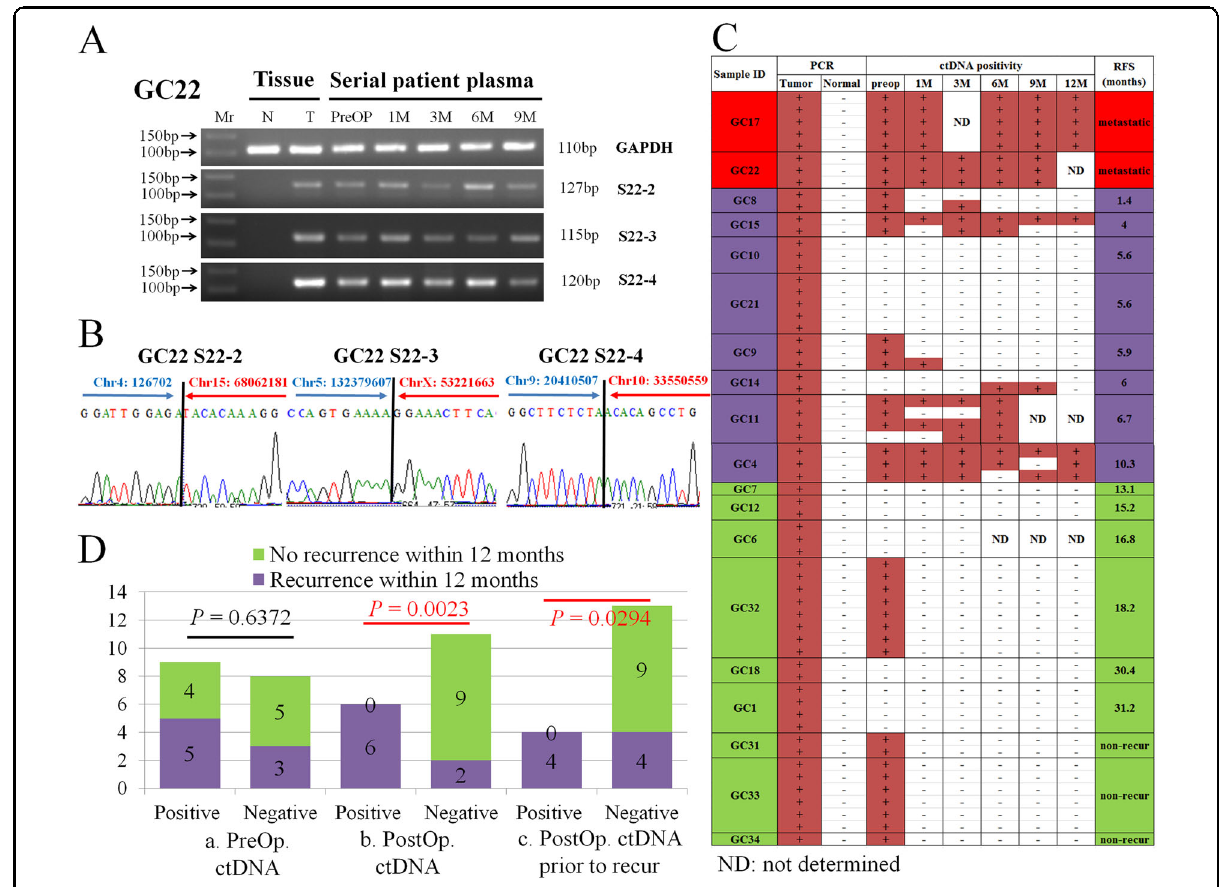
Fig. 3 Monitoring of ctDNA in serially collected plasma samples. a Con fi rmation of the rearrangements by PCR. Rearranged sequences (S22-2, S22-3, and S22-4) were ampli fi ed in preoperative (PreOP) and serial postoperative plasma samples collected at 1 – 9 months (1 M – 9 M) after surgery, along with normal (N) and tumor (T) tissue samples. Mr, molecular size markers. b Con fi rmation of three rearrangements (S22-2, S22-3, and S22-4) by Sanger sequencing. c ctDNA positivity in 19 gastric cancer patients. Each line indicates one personalized cancer-speci fi c rearranged marker: + positive ctDNA; − negative ctDNA; RFS, relapse-free survival in months. Cases of metastasis are marked in red; cases of recurrence within 1 year of surgery are marked in purple; and cases of recurrence after 1 year or cases of no recurrence are marked in green. d Correlation of ctDNA positivity with recurrent events within 12 months postoperatively. (a) Correlation of preoperative ctDNA positivity with recurrent events. (b) Correlation of postoperative ctDNA positivity with recurrent events. (c) Correlation of postoperative ctDNA positivity prior to clinical recurrence with recurrent